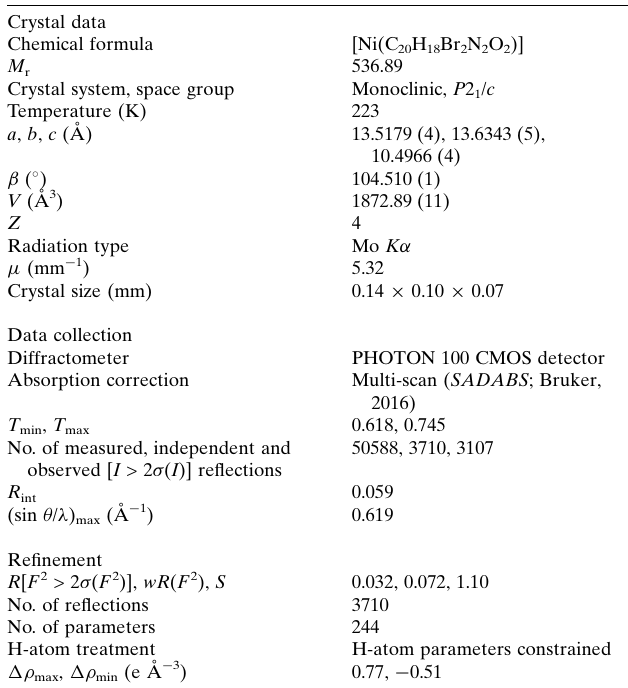
Table 2 Experimental details.